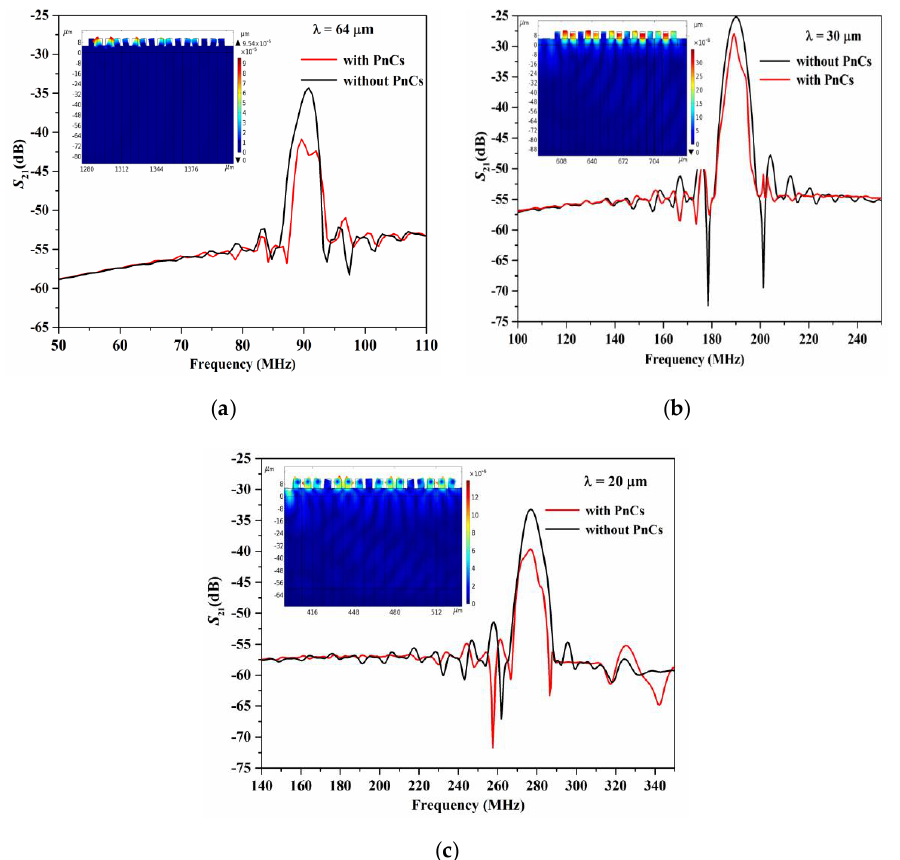
Figure 13. Insertion loss ( S 21 ) with (red solid lines) and without (black solid lines) PnCs for different SAW device wavelengths, ( a ) λ = 64 µm, ( b ) λ = 30 µm, and ( c ) λ = 20 µm closed to the eigenmodes A, C, and D.